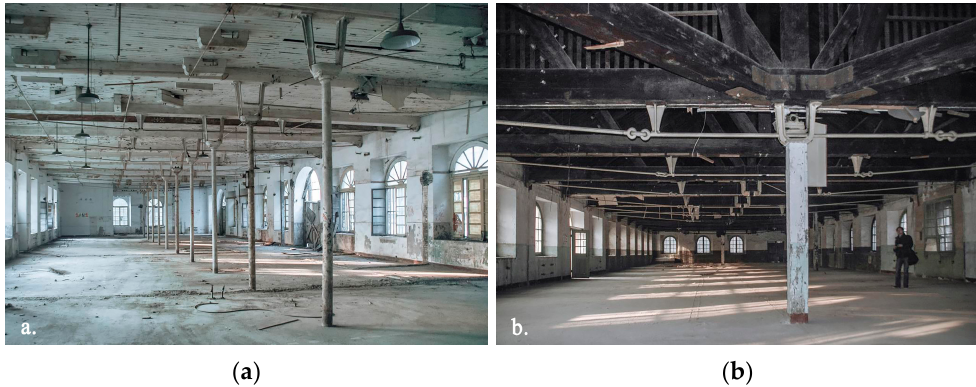
Figure 8. Structural system of string beams on the first ( a ) and second ( b ) floors. Pictures by X.X.